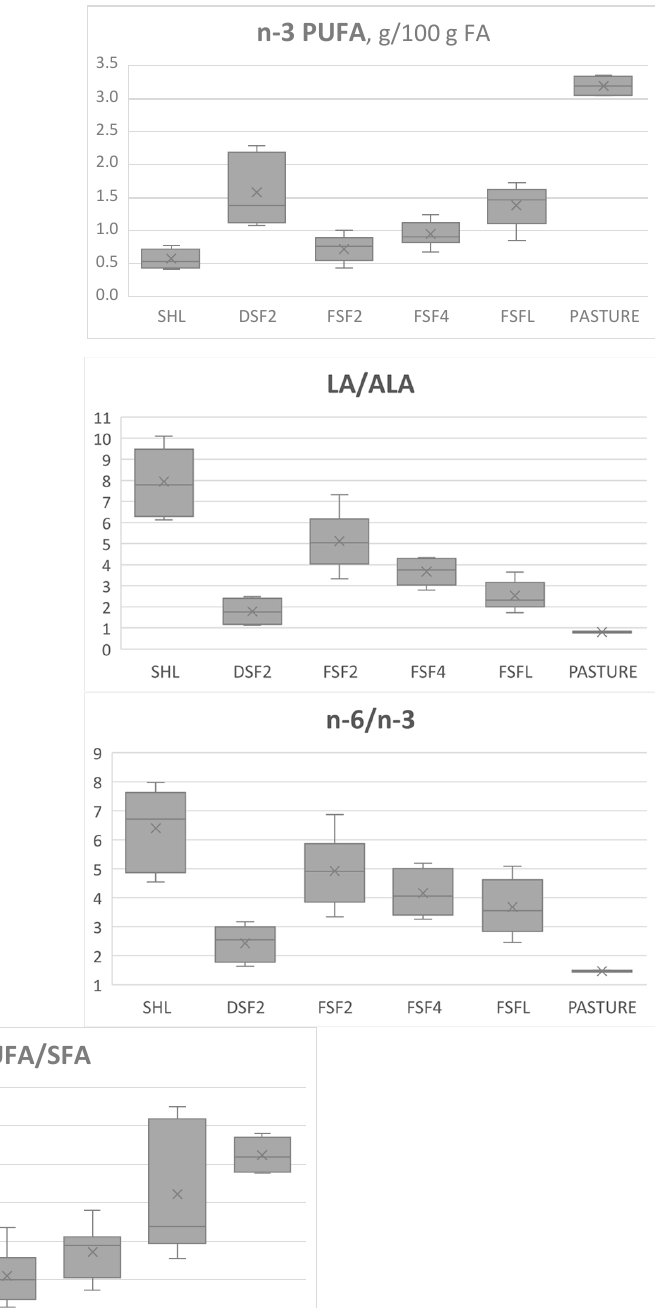
Figure 1. Linear and quadratic regressions of fresh forage intake (Y = % diet DM) to the level of α - linolenic acid (ALA) and the ratio linoleic acid/ α -linolenic acid (LA/ALA) in cheese (X) .